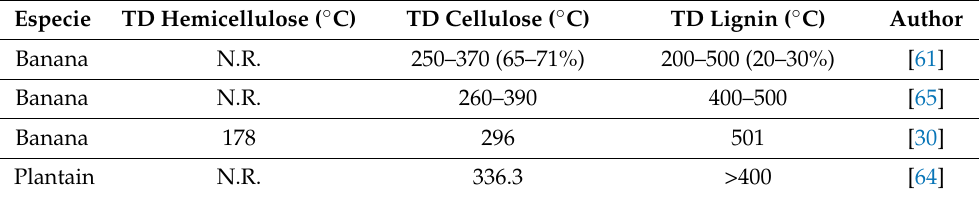
Table 5. Thermal degradation temperature (TD) in lignocellulosic fibres.